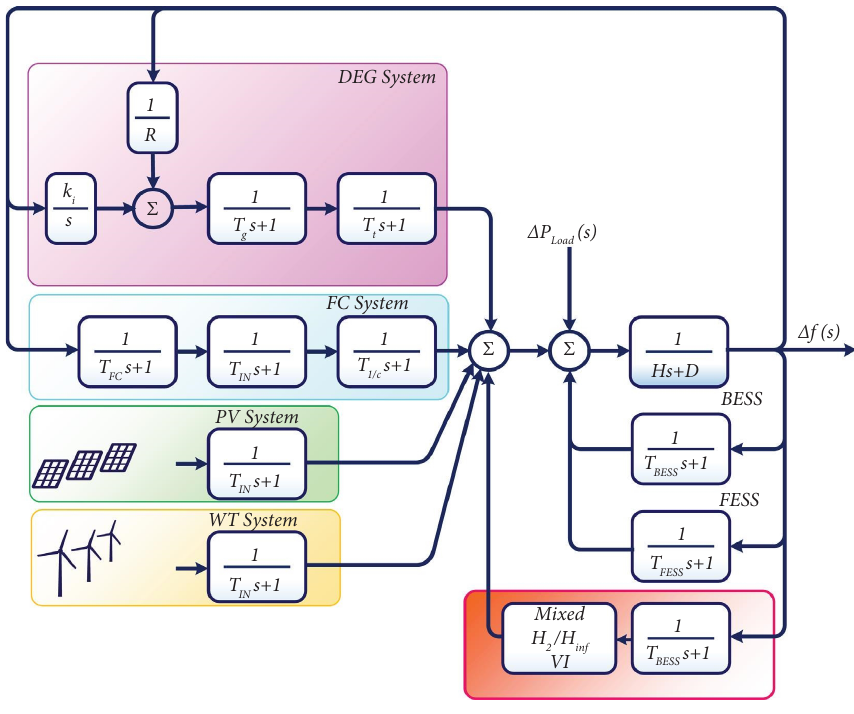
Figure 3: Laplace domain’s frequency response of an AC microgrid.